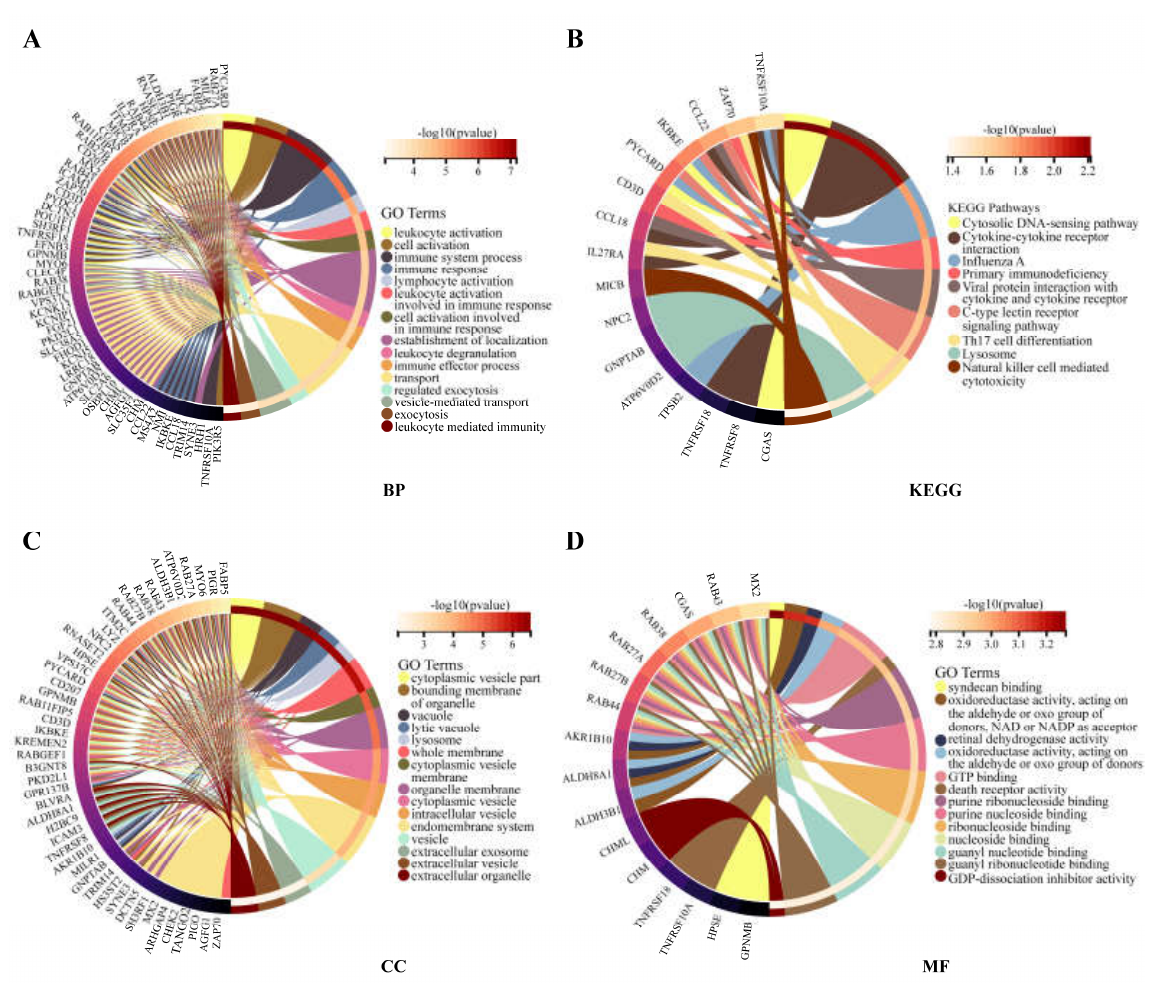
Figure 4. GO and KEGG analysis for RAB42-related genes. ( A ) BP, biological process. ( B ) KEGG, Kyoto encyclopedia of genes and genomes. ( C ) CC, cellular component. ( D ) MF, molecular func- tion.